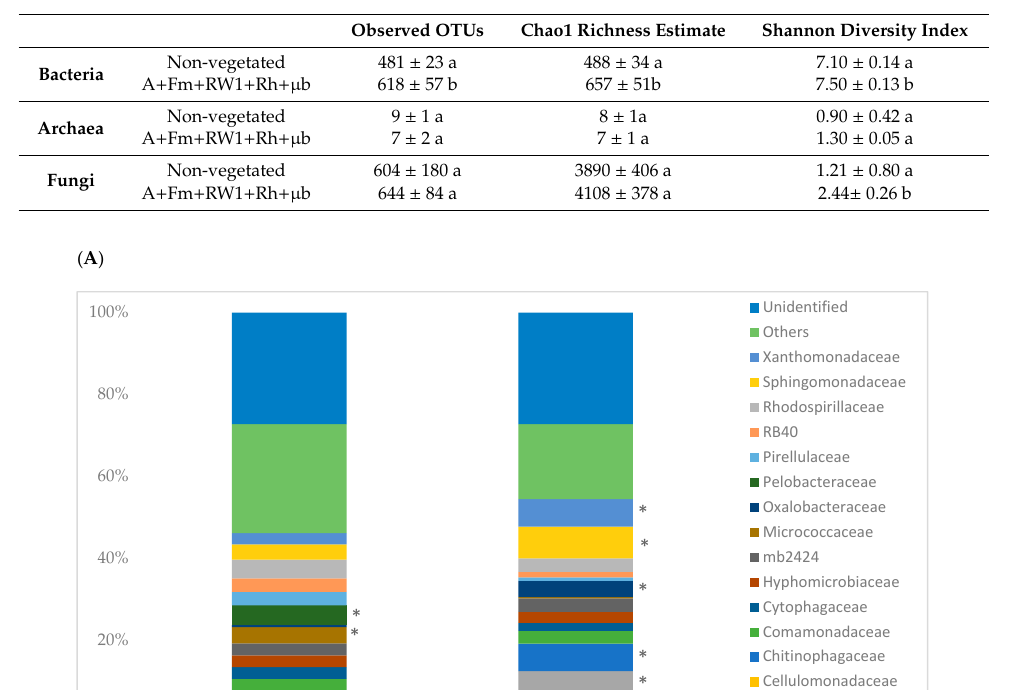
Table 6. Alpha diversity metrics for rhizosphere samples collected from non-planted polluted soil and in inoculated alfalfa with Fm plus RW1 plus Rh plus µ b (A + Fm + RW1 + Rh + µ b) grown in microcosms for six months. Values represent mean ± SD. Di ff erent letters indicate significant di ff erences between A + Fm + RW1 + Rh + µ b and non-planted soil according to Tukey (HSD) test on observed OTUs, Chao1 richness estimate, and Shannon diversity indices on the community structures of Bacteria, Archaea, and Fungi. Values are significant at p < 0.05.